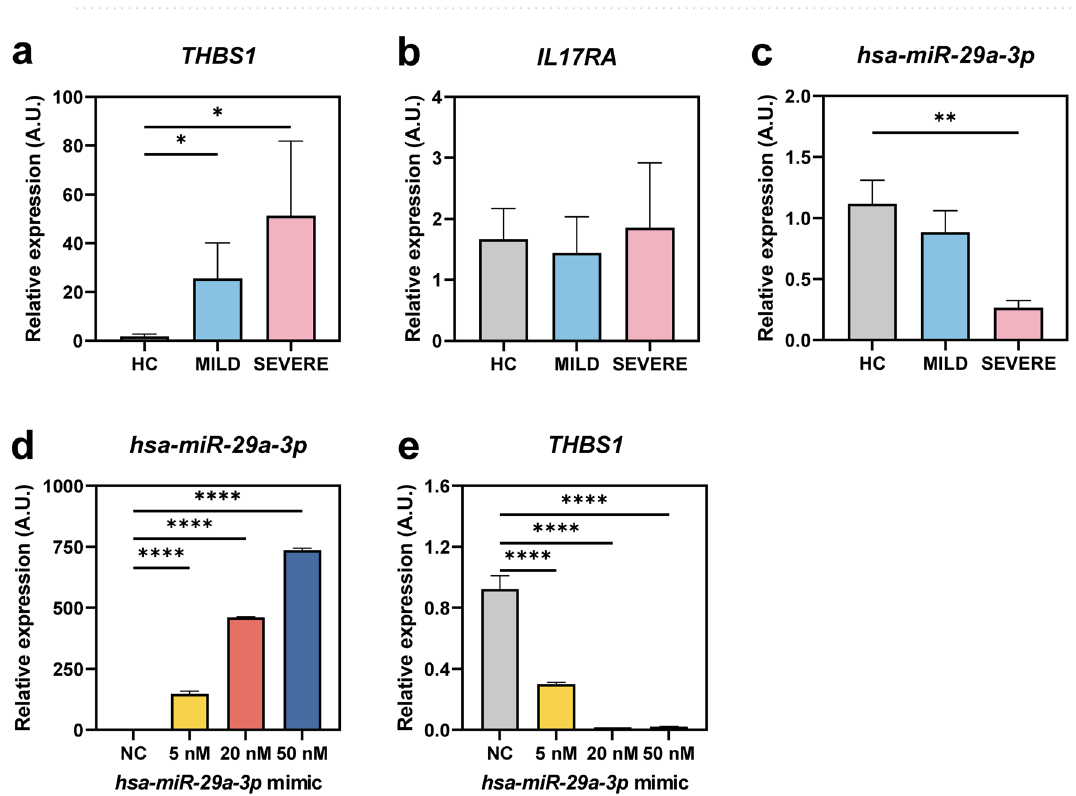
Figure 4. THBS1 is upregulated, but hsa-miR-29a-3p is downregulated, in PBMCs from severe patients, and THBS1 is targeted by hsa-miR-29a-3p . ( a – c ) Human PBMCs were isolated from mild (n = 8), severe (n = 7) patients and HCs (n = 8). THBS1 ( a ), IL17RA ( b ), and hsa-miR-29a-3p ( c ) expression levels were measured by qRT-PCR analysis. ( d , e ) THP-1 cells were transfected with either negative control (50 nM) or hsa-miR-29a-3p mimic (5, 20, 50 nM). After transfection, total RNA was extracted for the measurement of hsa-miR-29a-3p ( d ) and THBS1 ( e ) expression levels. Experiments were performed duplicate or triplicate and values are presented as means ± SEM ( a – e ). * P < 0.05; ** P < 0.01; *** P < 0.001; **** P < 0.0001. Kruskal–Wallis test ( a – c ) and One-way ANOVA ( d , e ). NC negative control of hsa-miR-29a-3p